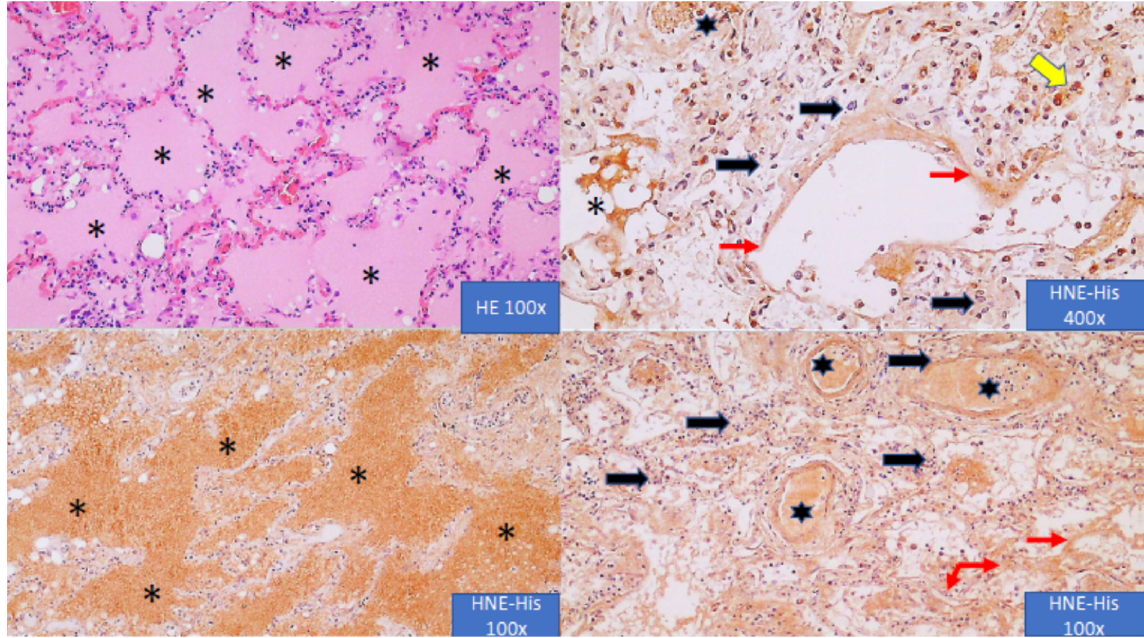
Figure 2. The immunohistochemical appearance of HNE in the lungs of the deceased COVID-19 patient. Eosinophilic (HE) liquid of edema in the alveoli (asterisks) shows abundant HNE content (HNE-His giving brown-colored immunopositive reaction of DAB staining). However, inflammatory mononuclear cells in the alveoli and in their septa (black arrows) are mostly negative for HNE (only blue-colored hemotoxylin contrast staining is present), with some macrophages are positive for HNE (yellow arrow). On the contrary, blood vessels (both their walls and the blood content, indicated by the black stars) are HNE-positive, as are the hyaline membranes on the surface of the alveolar septa (red arrows). Conclusion—HNE might be responsible for the fatal outcome, but more likely due to the systemic, vascular oxidative stress (sepsis-like, originating from the blood), not due to the pulmonary inflammatory cells, which are mostly negative for